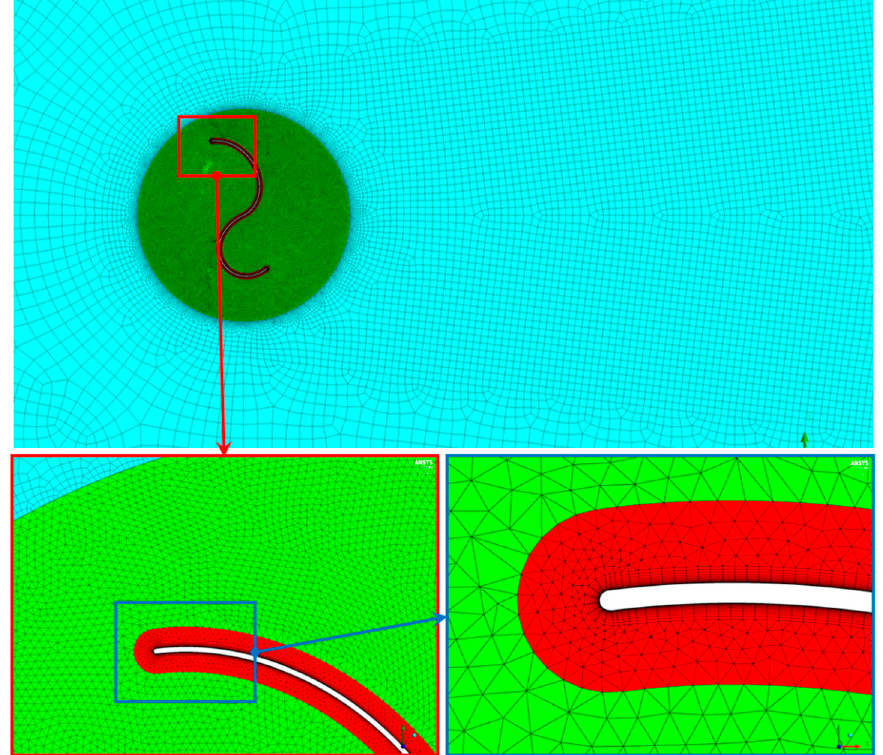
Figure 4. Computational mesh in the external and internal domains with details of its refinement in the blade vicinity presented in the successive magnifications.